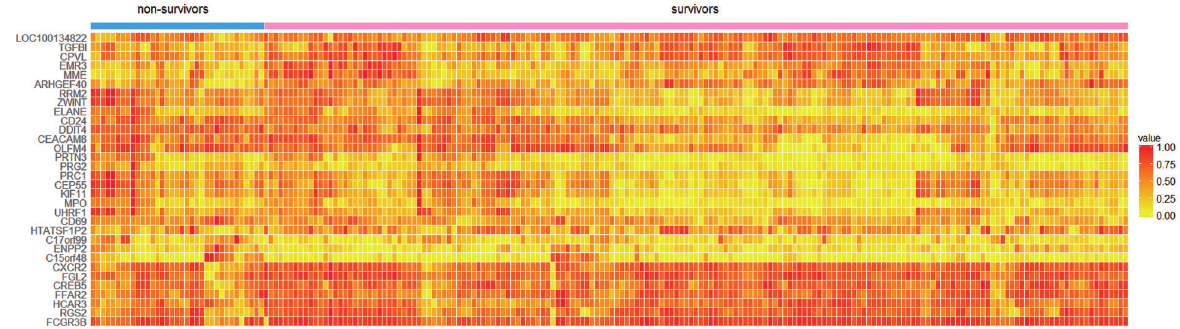
Figure 1. Heatmap of expression data for 32 differentially expressed genes in the collection of 3 training datasets.